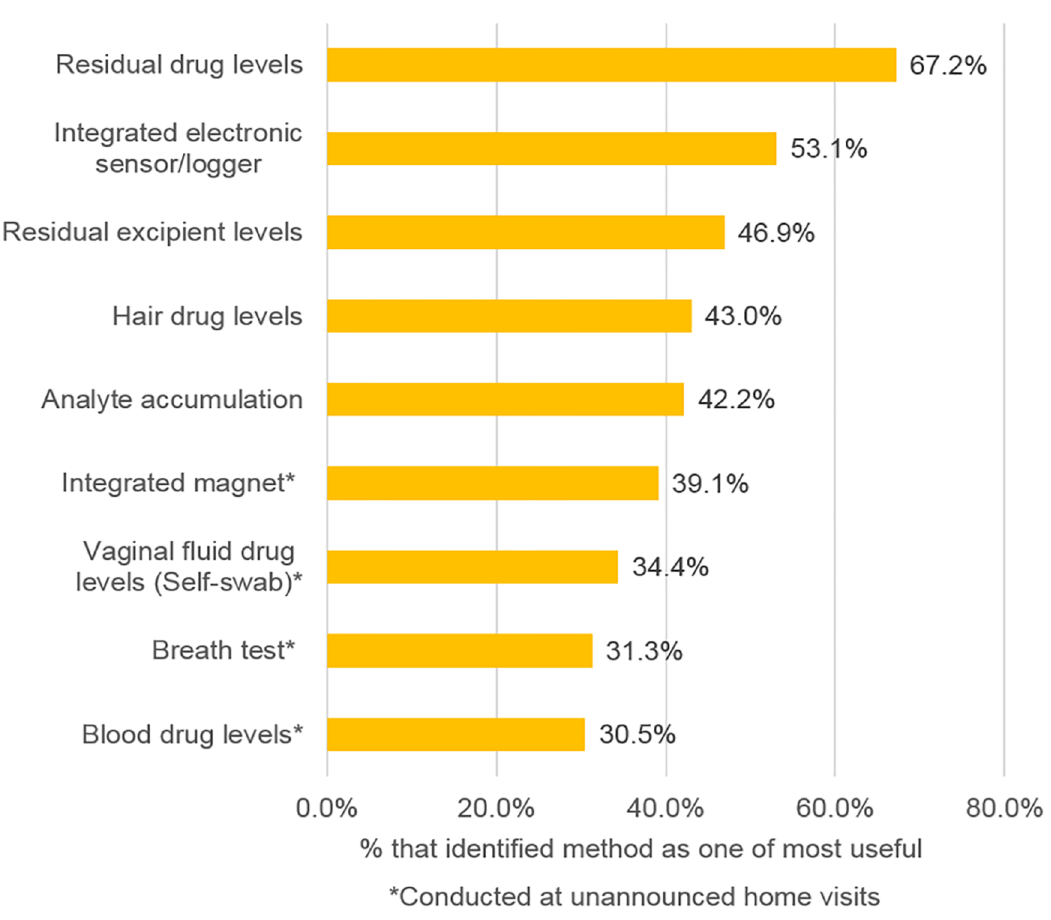
Fig 3. Respondents’ views on usefulness of measuresfor measuring adherence (n =